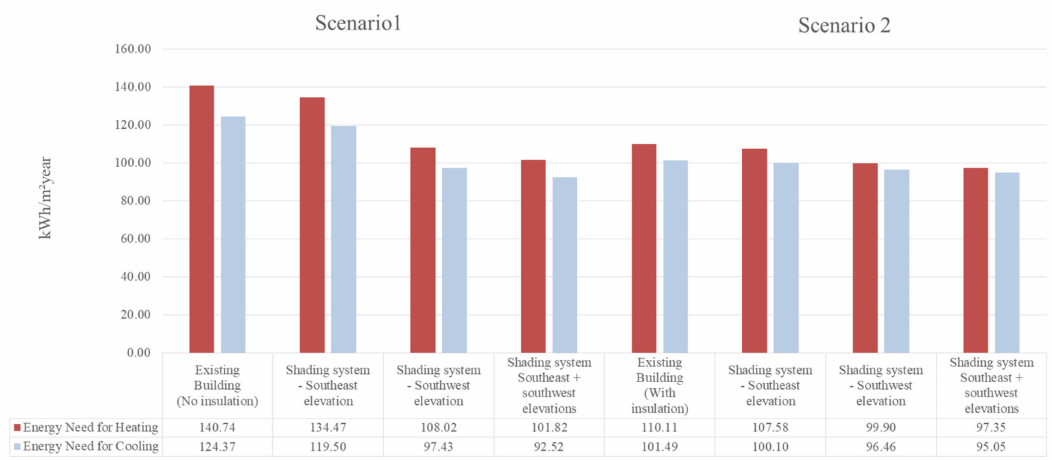
Figure 14. Calculation of the energy need (kWh/m 2 year) with DesignBuilder—scenarios 1 and